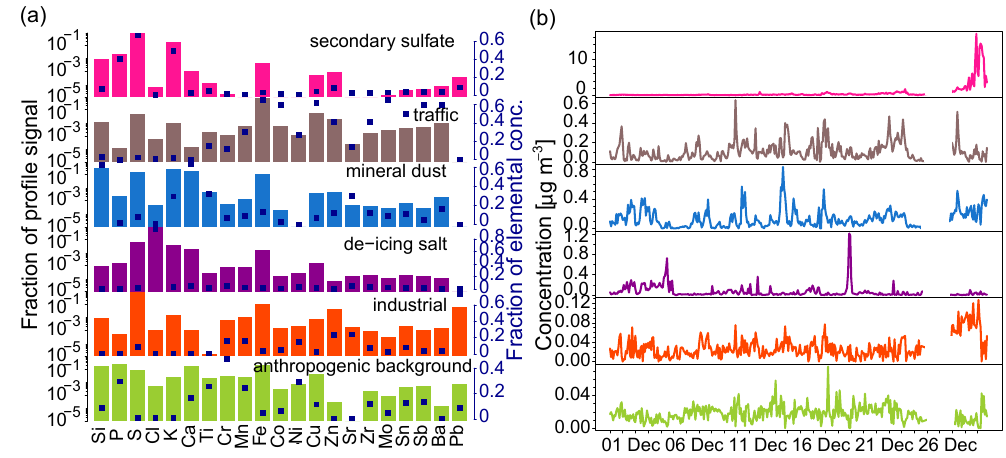
Fig. 6. PMF results for PM 2 . 5 − 1 , (a) factor profiles, from top to bottom: secondary sulfate, road traffic, mineral dust, de-icing salt, industrial and local anthropogenic background. The solid bars (left y -axis) represent the amount of each species apportioned to the factor and the blue squares (right y -axis) represent the fraction of the total of each species, (b) corresponding time series.